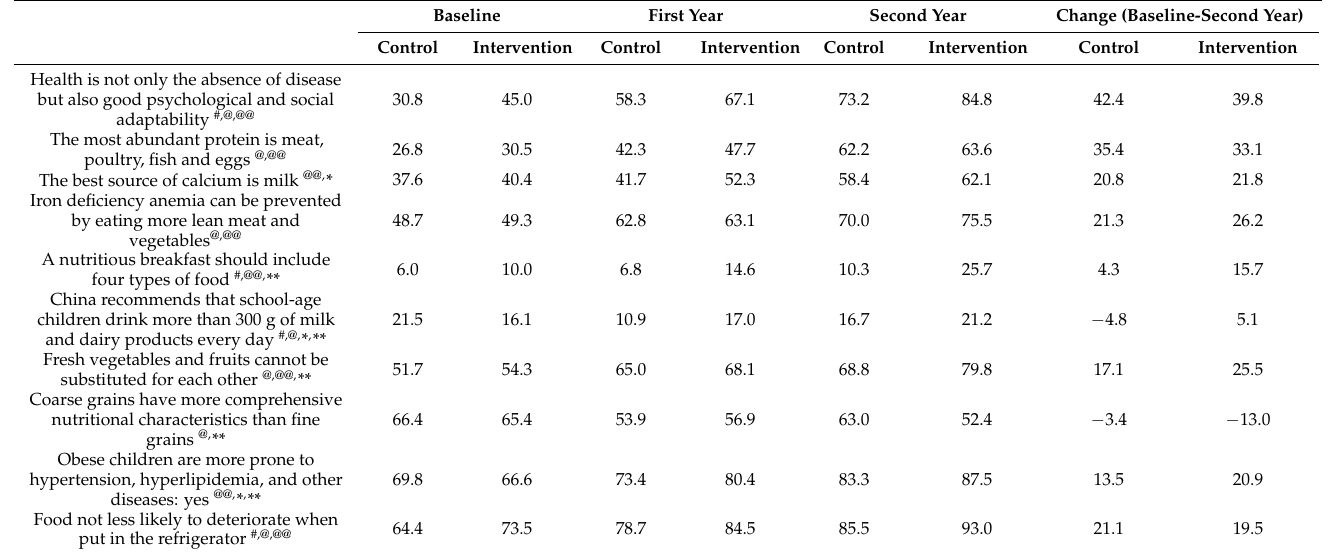
Table 3. Comparison of correct rate of children’s nutrition knowledge between the intervention group and control group (%).